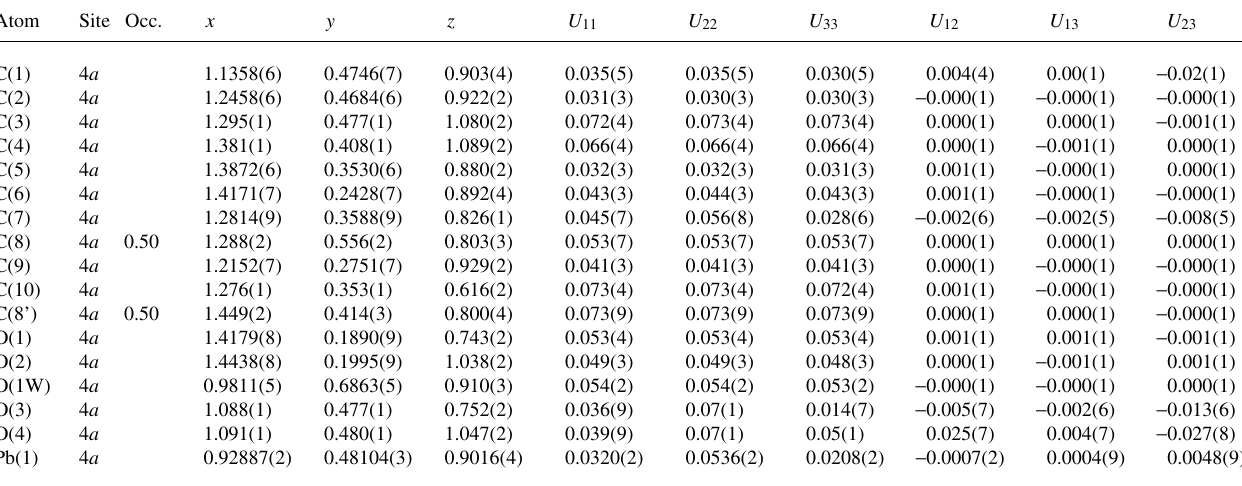
Table 3. Atomic coordinates and displacement parameters (in Å 2 )